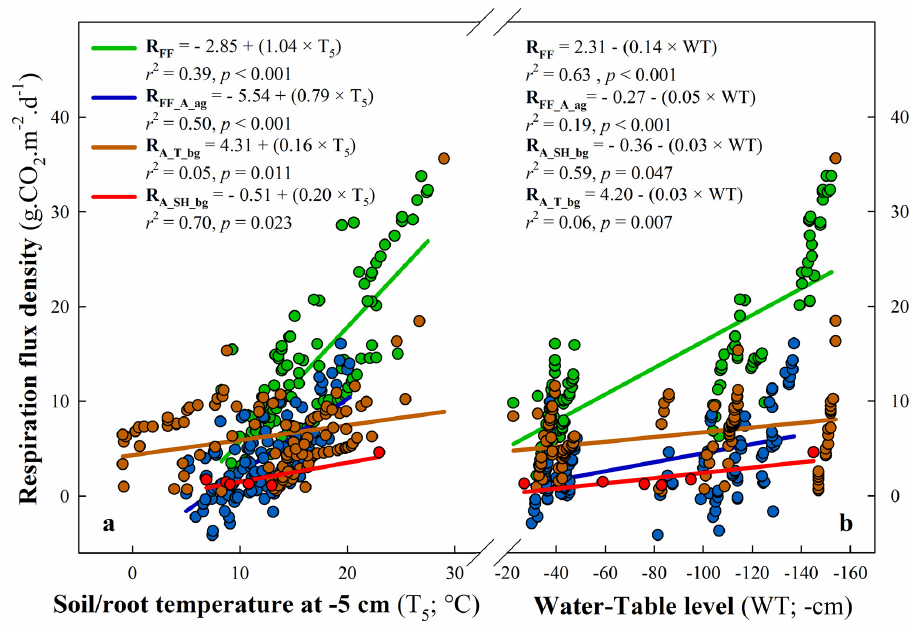
Figure 3. ( a ) Forest floor respiration flux (R FF ; g · CO 2 · m − 2 · day − 1 ), aboveground autotrophic respiration flux of forest floor (R FF_A_ag ; g · CO 2 · m − 2 · day − 1 ), belowground autotrophic respiration of shrubs + herbs (R A_SH_bg ; g · CO 2 · m − 2 · day − 1 ), and belowground autotrophic respiration of tree roots